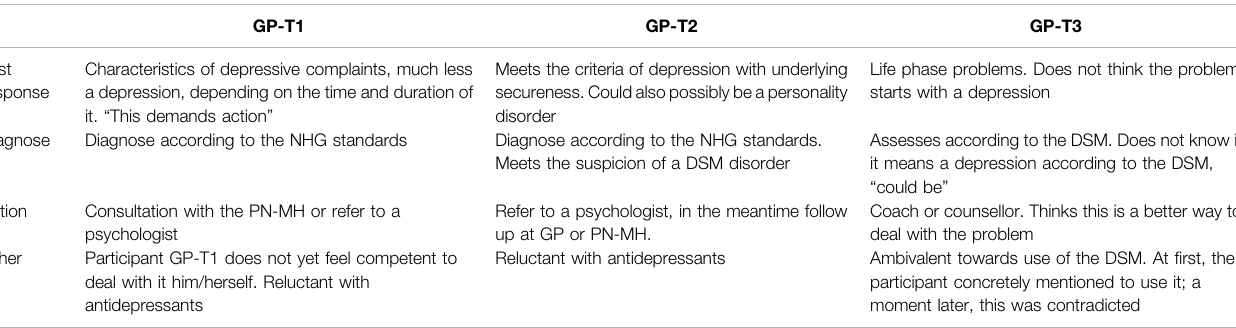
TABLE 4 | GPs in training assessment and